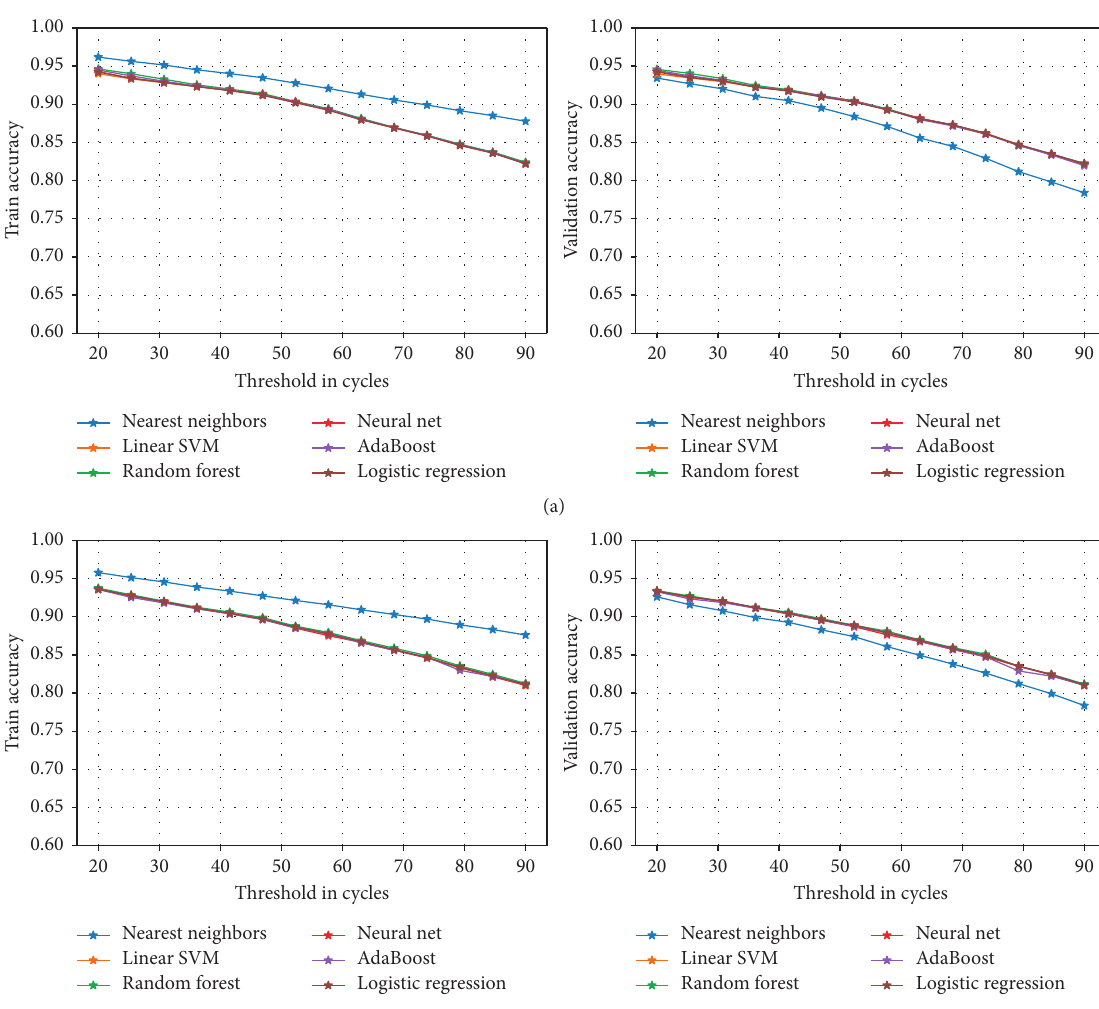
Figure 6: Threshold sensibility analysis for six machine learning classifiers for the health state of the system based on the trained latent variable x . (a) FD001. (b) FD004.